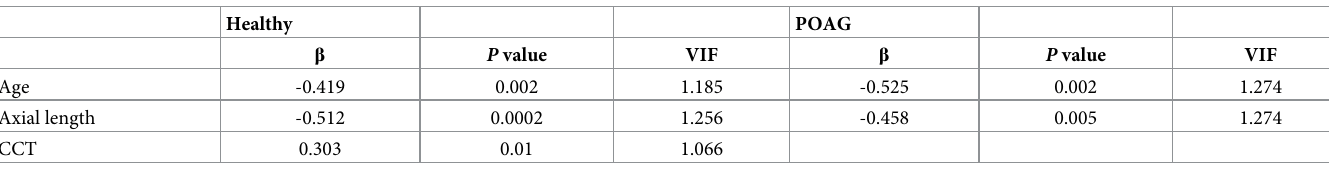
Table 4. Multivariate regression analysis of macular choroidal area with associated